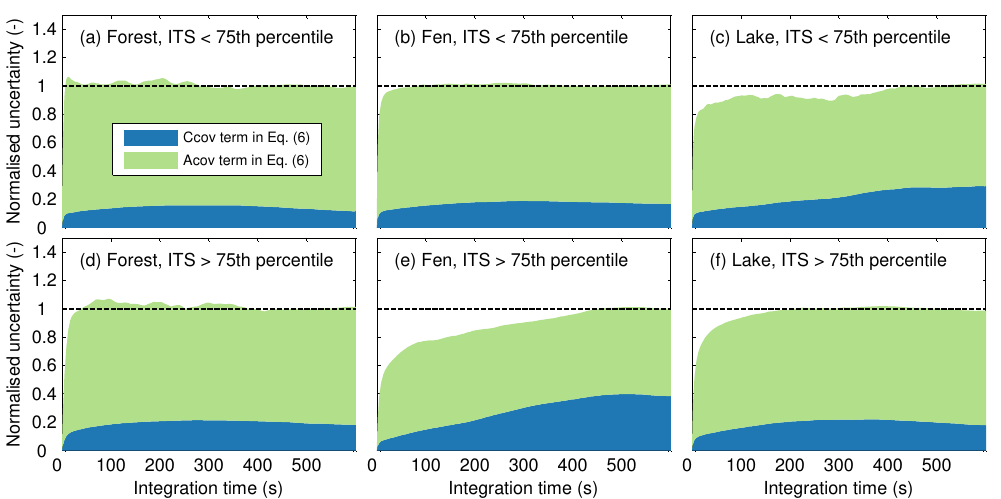
Figure 10. Normalised uncertainty estimate according to Finkelstein and Sims (2001), ˆ δ F,FS , as a function of integration time used in Eq. (6). Contribution of the cross-covariance (blue area) and auto-covariance (green area) terms in the Eq. (6) are shown separately. The values were normalised with average ˆ δ F,FS at integration times between 400 and 600s and grouped in two ITS classes before plotting. No detrending of time series was